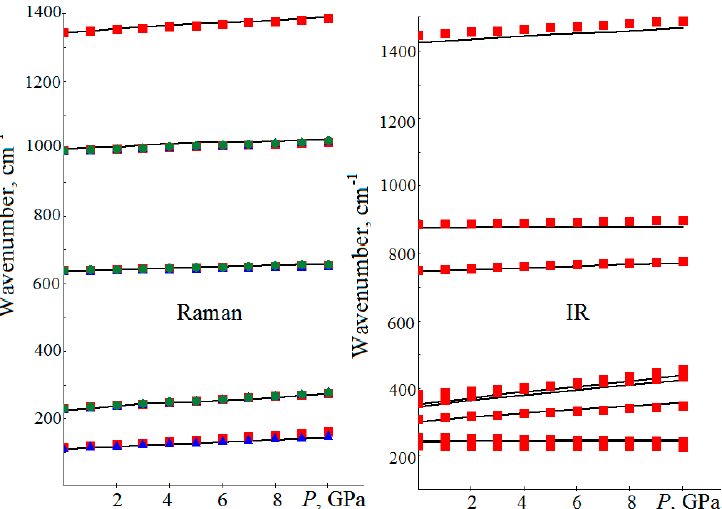
Figure 3. Calculated (the calculation is solid lines, squares, circles and triangles—the experiment) dependences of MgCO 3 vibrational modes wavenumbers on the P pressure, active in the Raman spectrum (on the left, squares—the data from [20], triangles from [22], circles from [9]) and the infrared spectrum (on the right, squares—the data from [7]).